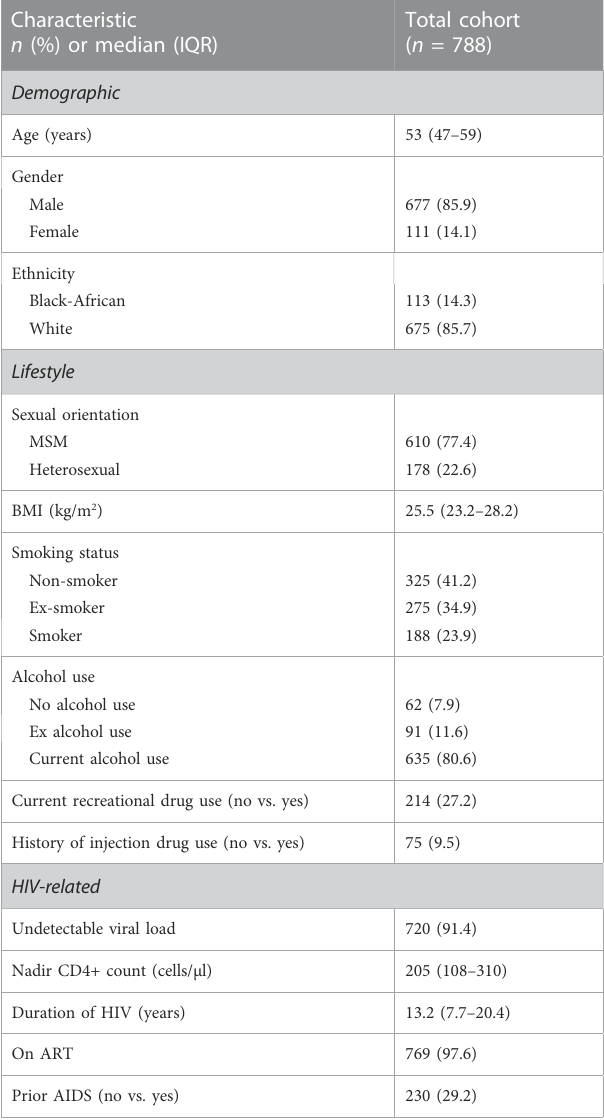
TABLE 1 Demographic, lifestyle and HIV-related characteristics of POPPY participants with HIV ( n = 788).